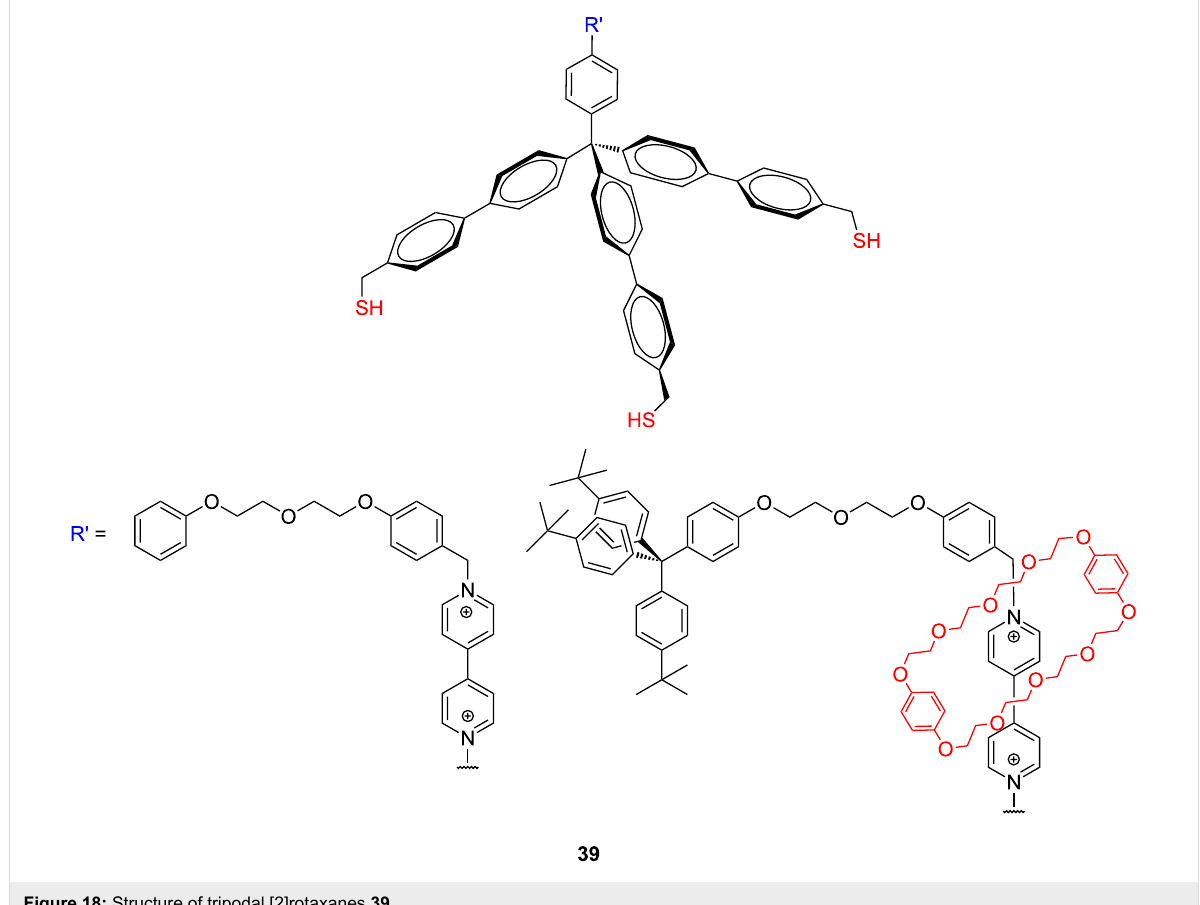
Figure 18: Structure of tripodal [2]rotaxanes 39